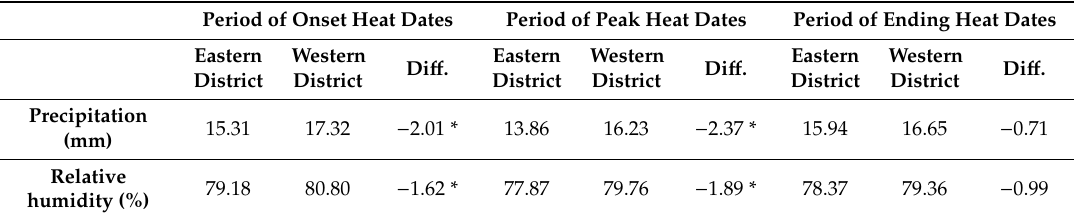
Figure 2. Climatological patterns of 850-hPa geopotential height (m) and wind vectors (m s − 1 ) for the periods of ( a ) onset heat dates, ( b ) peak heat dates, and ( c ) ending heat dates. Table 4. The differences in precipitation and relative humidity for the periods of onset, peak, and ending heat dates between the eastern and western districts of the Sobaek and the Taebaek mountain ranges. Note that the differences were calculated by subtracting the values of the eastern districts from those of the western districts.